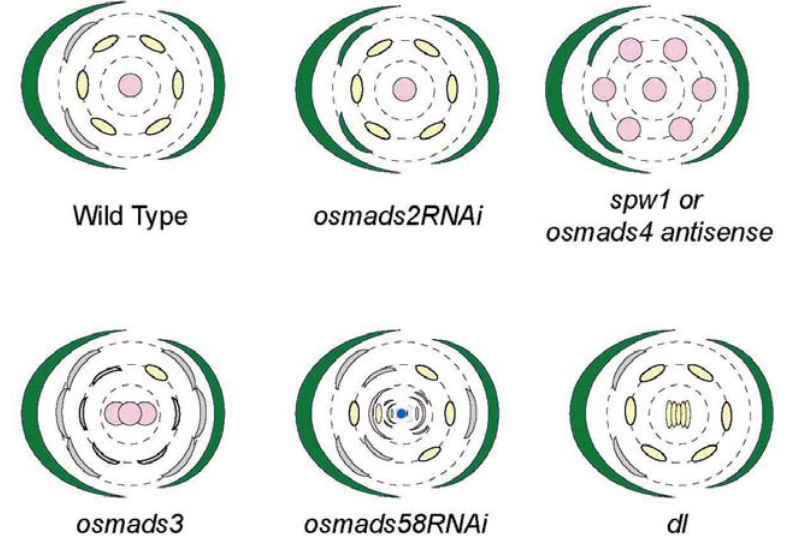
FIGURE 3. Phenotypes of the wild-type flower and floral homeotic mutants. Lemma, palea, and ectopic glume-like organs are indicated in green; lodicules, stamens and carpels are indicated in gray, yellow, and pink, respectively. The blue circle in the osmads58RANi flower indicates an indeterminate floral meristem, which produces reiterative sets of lodicules, stamens, and abnormal carpel-like